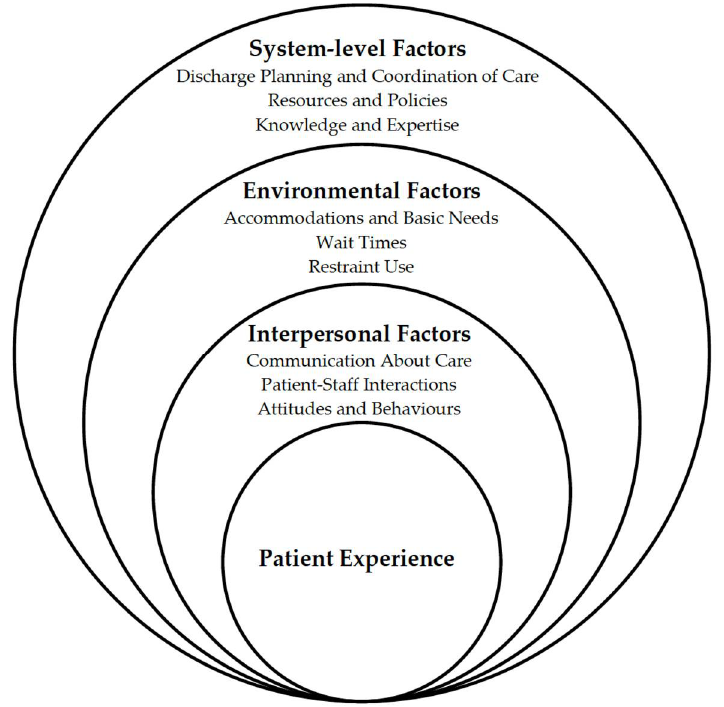
Figure 2. Conceptualization of the key themes identified through thematic analysis of patient and provider perspectives, adapted from Bronfenbrenner’s socio-ecological model [46] . provider perspectives, adapted from Bronfenbrenner’s socio-ecological model